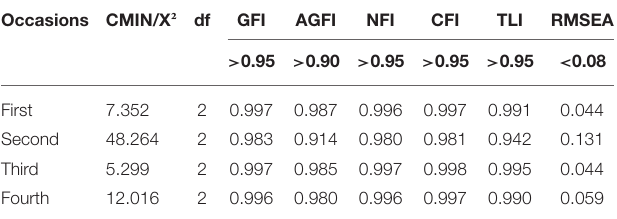
TABLE 4 | Fit statistics for four occasions of hypothetical model 1 of PRETCO-oral. Occasions CMIN/X ² df